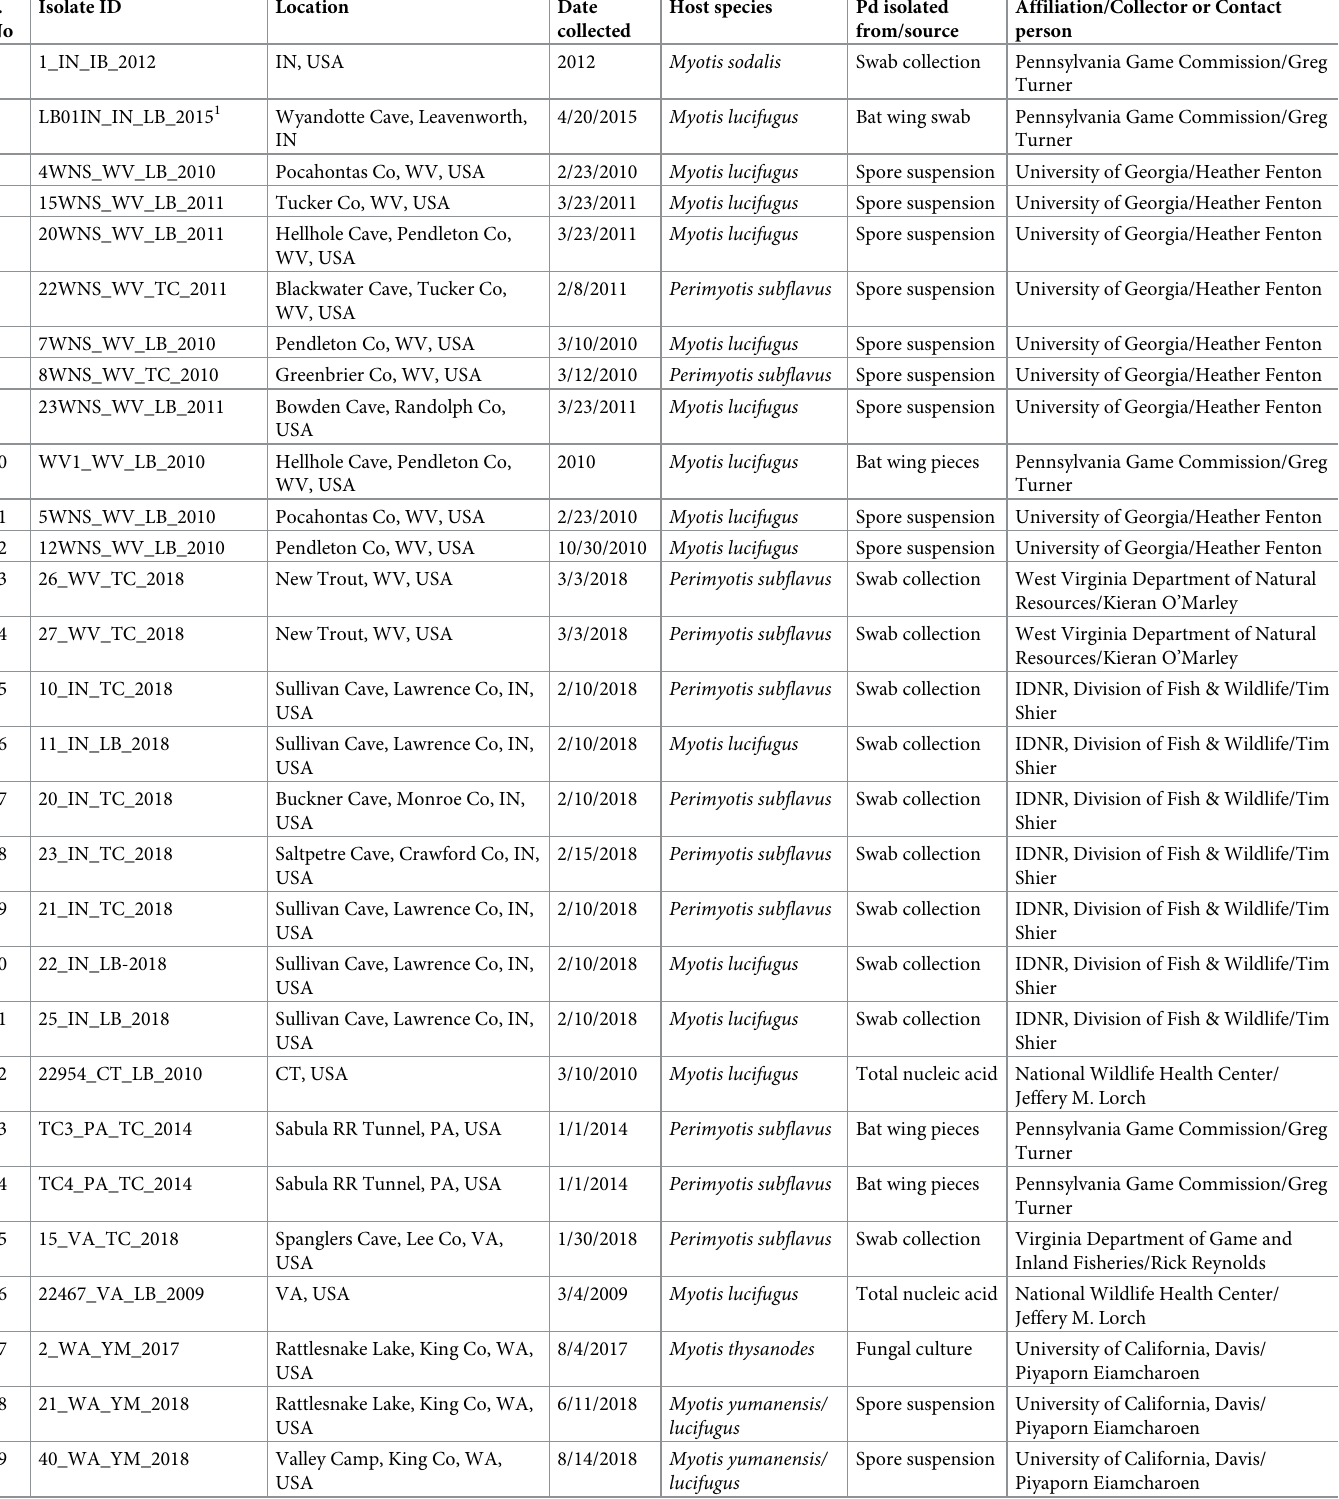
Table 1. Description of Pseudogymnoascus destructans (Pd) isolates used in this study. S. Isolate No